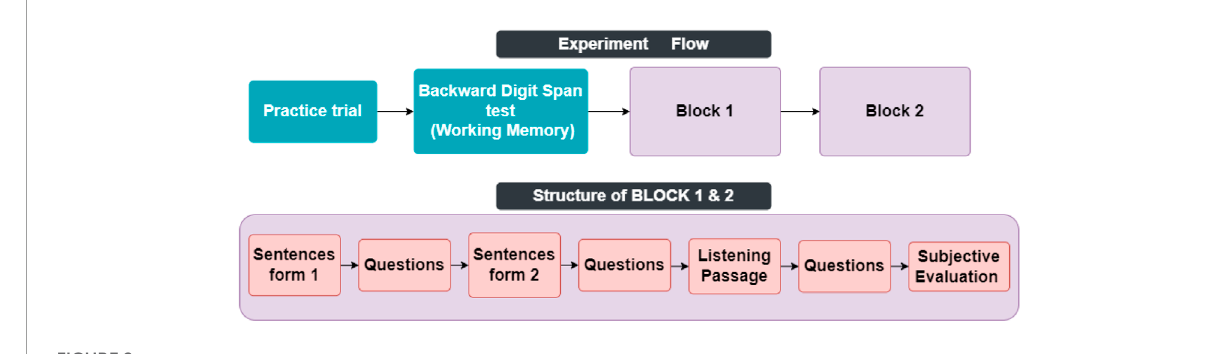
FIGURE 2 Task flow of each experiment. (A) shows the task flow of the experiment, and (B) shows the content of each